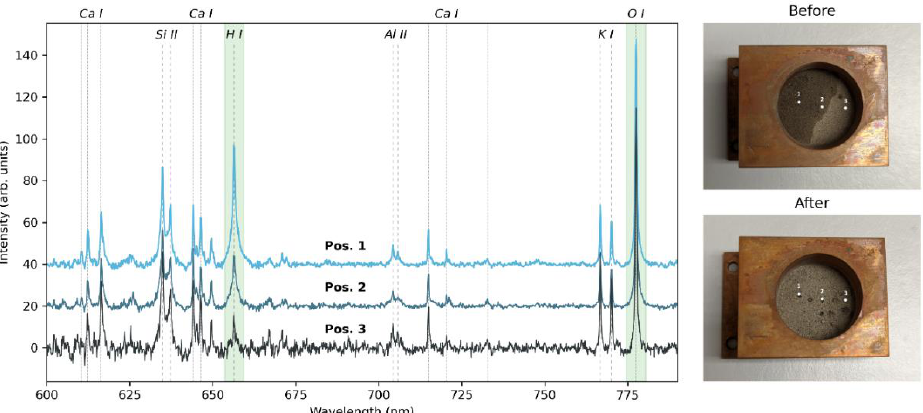
Figure 6. ( left ). VOILA spectra of the lunar regolith mixed with water ice at different positions, where position 1 contains the most water ice and position 3 contains the least. The spectra have been normalized by their total intensity and the spectral lines of H I and O I are highlighted in green. ( Right ): images of the sample before ( top ) and after ( bottom ) freezing and measuring, with labels for the three measurement positions.